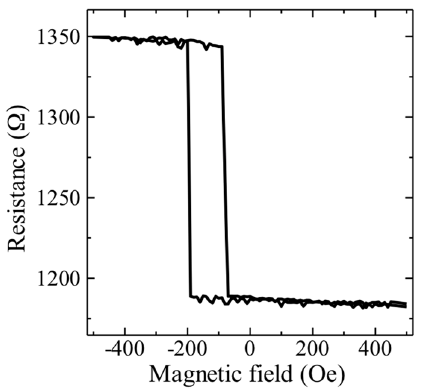
Figure 6. Magneto-resistance characteristics of the LM element in the spin-SLM. Table 1. Electrical characteristics of the two